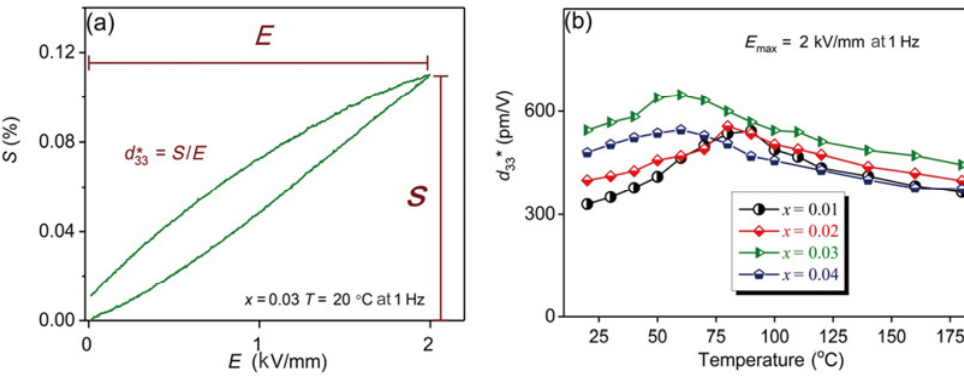
d * (calculated by S max / E max , E max = 33